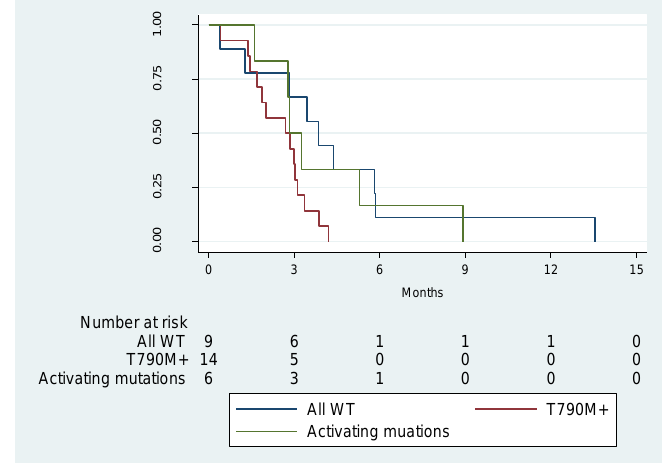
Figure 2. Kaplan‐Meier survival estimates of progression free survival (PFS) of the three groups: double positive (p.T790M and EGFR sensitizing mutation); single positive (only for the EGFR sensitizing mutation) and double negative (no EGFR mutations), according to digital droplet PCR (ddPCR) serum analysis.